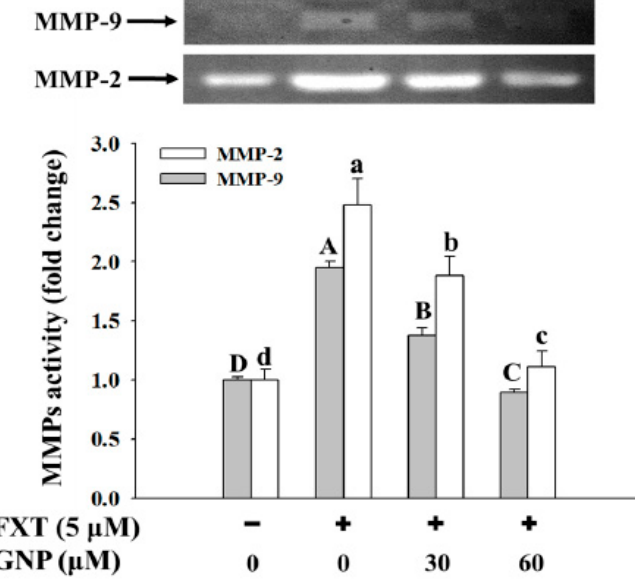
Figure 6. Ameliorating effect of GNP on the FXT-induced MMP-2 and MMP-9 activities in HepG2 cells. HepG2 cells were seeded onto a 6-well plate at 5 × 10 5 cells/mL and incubated overnight, treated with FXT and GNP at dose as indicated and further incubated for 72 h. DMSO (0.1%) was used as vehicle control. Values are expressed as mean ± SD ( n = 3). Different letters indicate statistical significance ( p < 0.05).